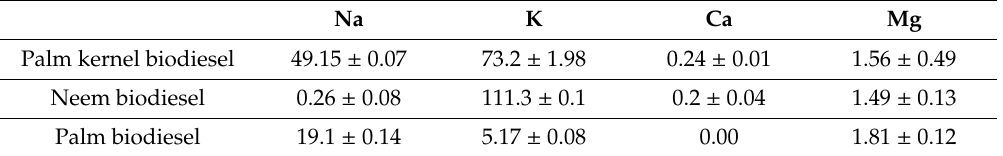
Table 2. Na, K, Ca, and Mg content of di ff erent biodiesel samples (mg / kg). Adapted from Reference [14].